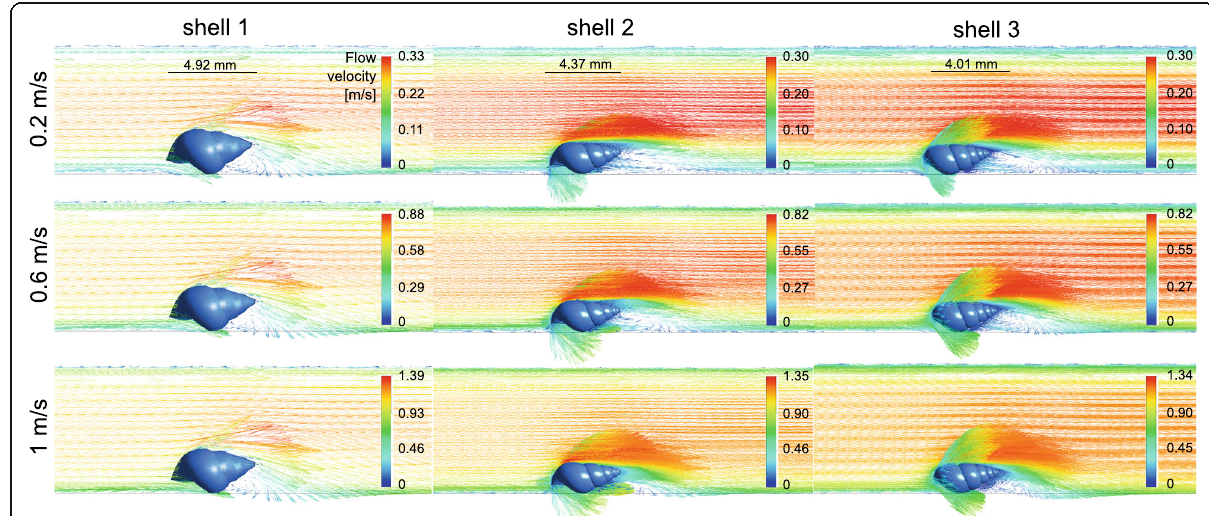
Fig. 5 Lateral view of the flow environment around the STL shell models 1 – 3 at three different flow velocities. Original flow direction in the channel from left to